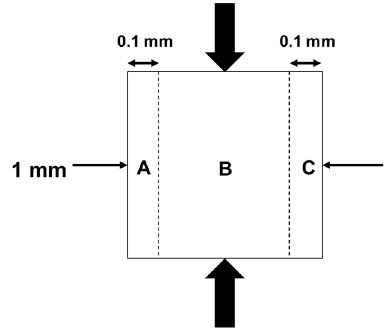
Figure 13. Illustration of the compression load along sample cross-section.